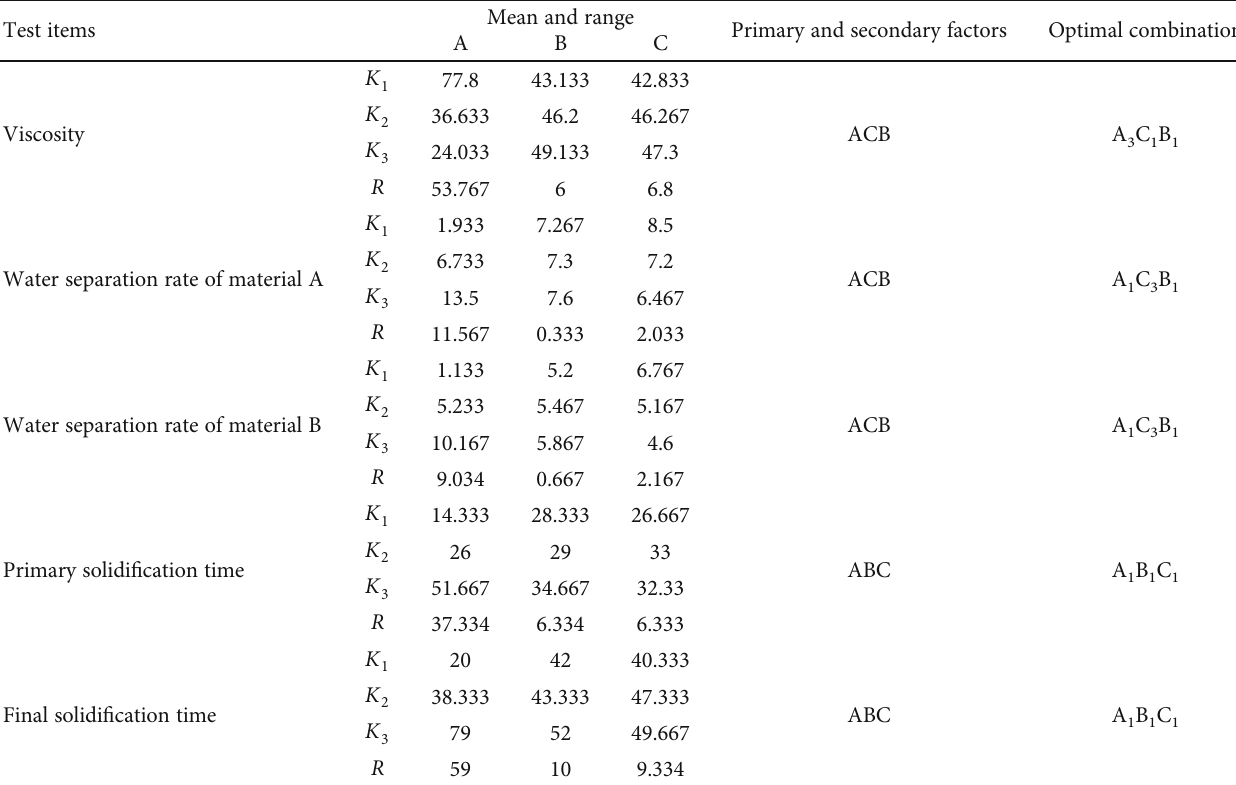
Table 4: Range analysis table of slurry physical